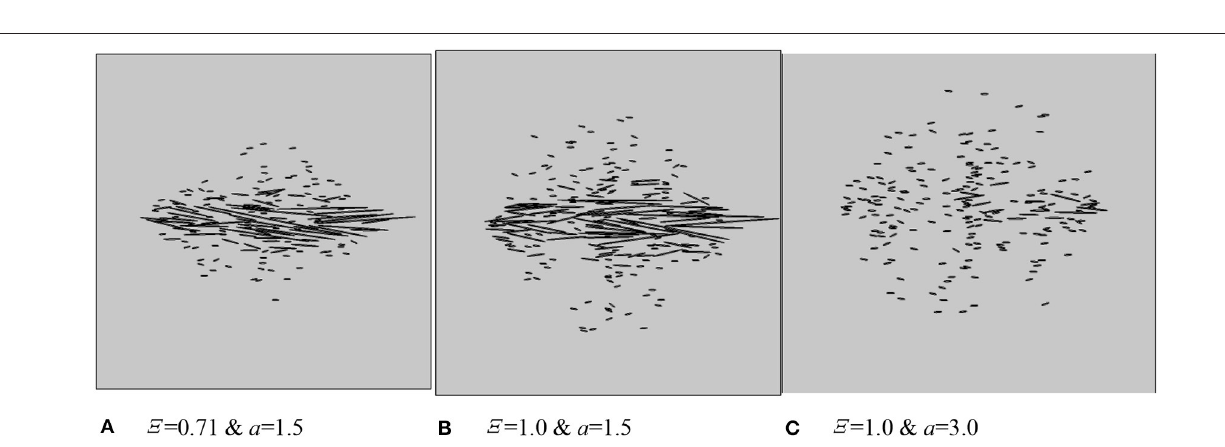
FIGURE 5 | Three different fractured models with various length distributions (A) and spatial distributions ( 4 ). The relating characteristic exponent a and the aspect ratio 4 are given at the bottom of each plot. (A) 4 = 0.71 & a = 1.5; (B) 4 = 1.0 & a = 1.5; (C) 4 = 1.0 & a =